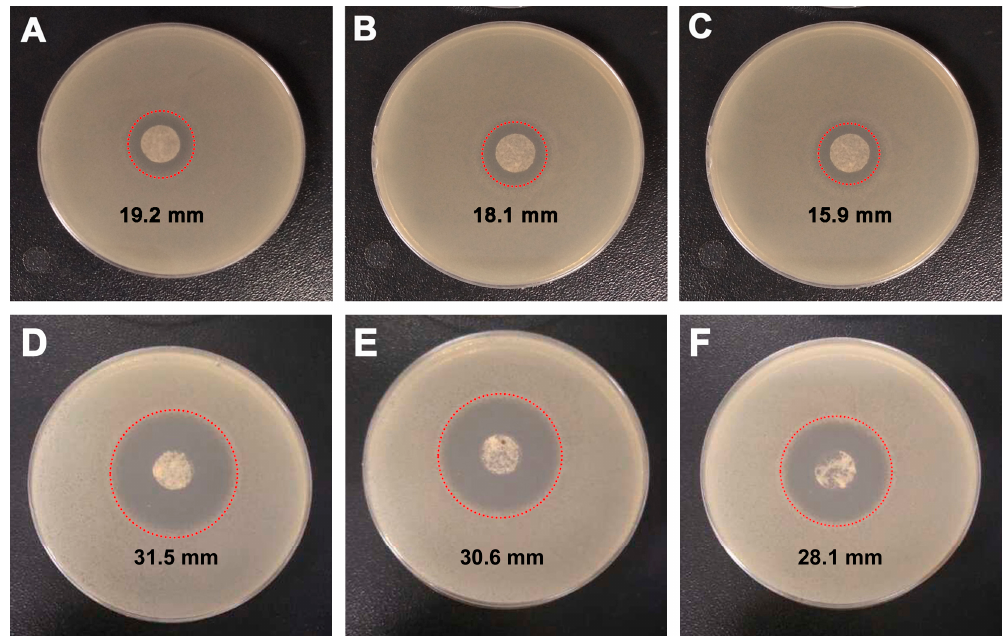
Figure 9. ( A – C ) Photographs of the inhibition zone of cSG-PAN prepared with different feed ratios of cSG to PAN against E. coli : ( A ) 1:5; ( B ) 1:10; and ( C ) 1:20. ( D – F ) Photographs of the inhibition zone of cSG-PAN ( D ) before and ( E ) after one month of storage at 25 °C and 65% RH and ( F ) after washing durability test.